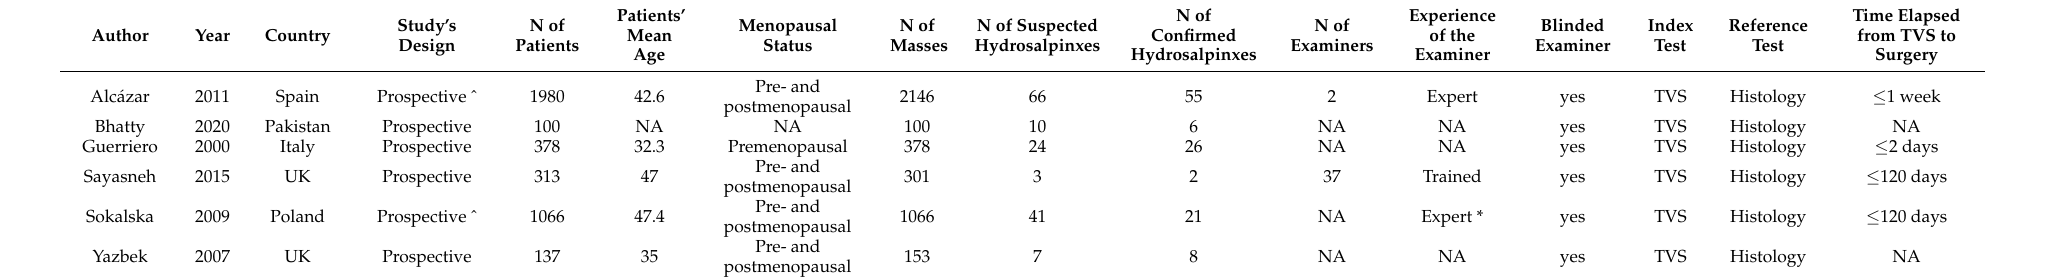
Table 1. Main characteristics of the studies included in the meta-analysis (according to PICOS criteria).